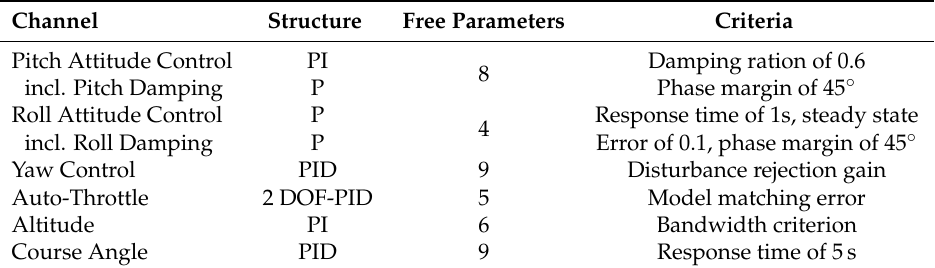
Table 2. Overview of the six defined optimization problems with the number of free parameters and optimization criteria within the model-based design procedure of the baseline